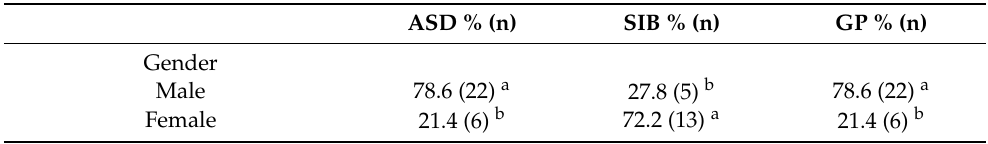
Table 1. General demographic characteristics of the study population. Values showing different letters ( a, b ) at the right side indicate significant differences ( p -value < 0.05) in gender among the different groups of children. ASD, Autism Spectrum Disorder; SIB, Siblings; GP, General Population. CARS: Childhood Autism Rating Scale, 2nd